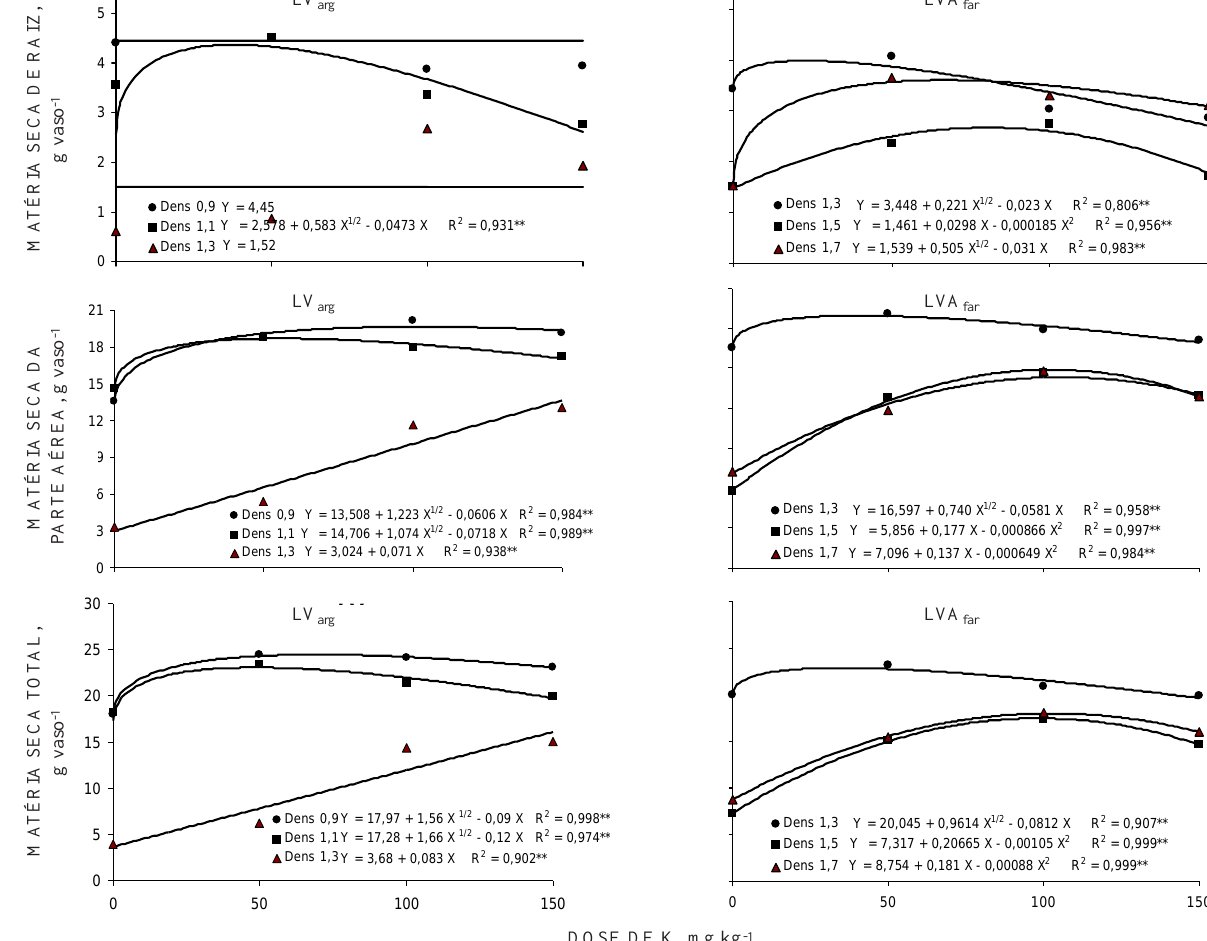
) e franco-arenosa (LVA ), com diferentes densidades e arg far